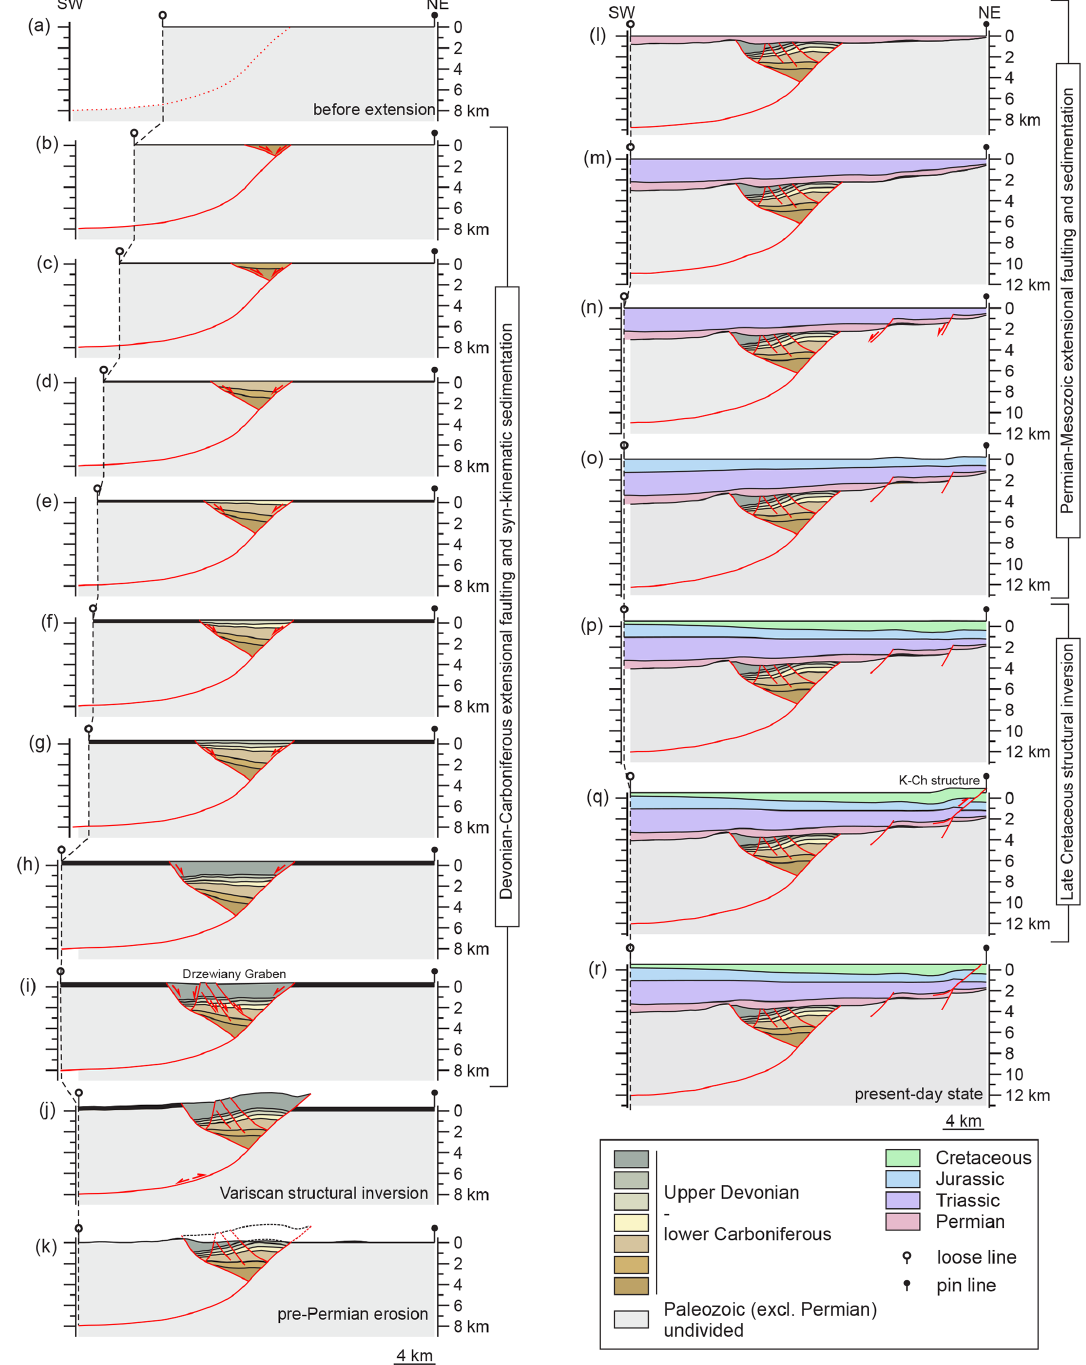
Figure 8. Balanced model constructed for the NE part of the regional transect from Fig. 6a. It illustrates Late Devonian (Frasnian– Famennian?)–early Carboniferous (Tournaisian) extension and subsidence (a–i) , late Carboniferous inversion followed by post-inversion erosion (j–k) , Permo-Mesozoic subsidence within the peripheral part of the Mid-Polish Trough (l–o) , Late Cretaceous–Paleogene inversion and uplift (p–q) , and present-day geometry (r) . K-Ch structure: the Koszalin–Chojnice structure.